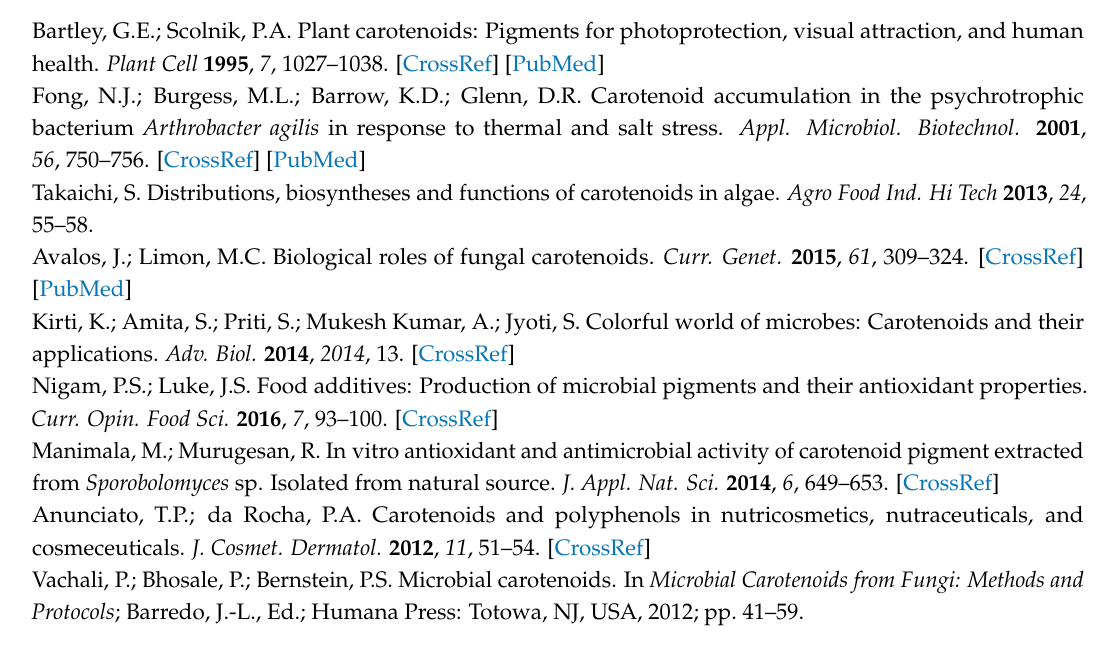
( ), 0.137 M ( ), 0.2 M ( ), 0.3 M ( ), 0.41 M ( ) and 0.5 M ( ) NaCl. ( b ) β -carotene